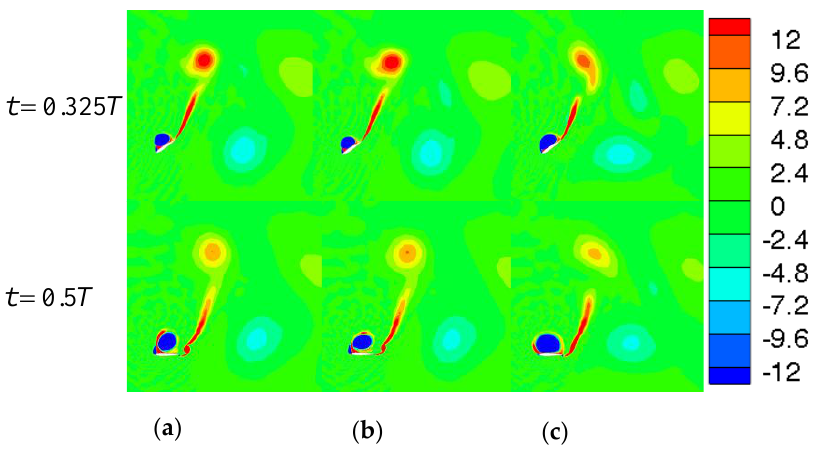
Figure A2. Instantaneous vorticity contours at t = 0.325 T , 0.5 T for di ff erent turbulence model: ( a )